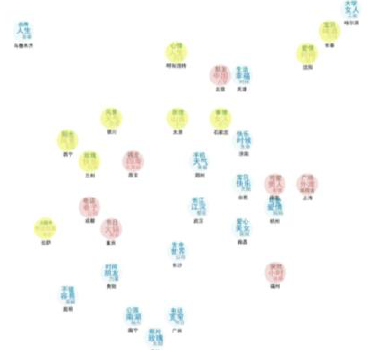
Figure 1. Top three words in big cities of China with the “Taggram”